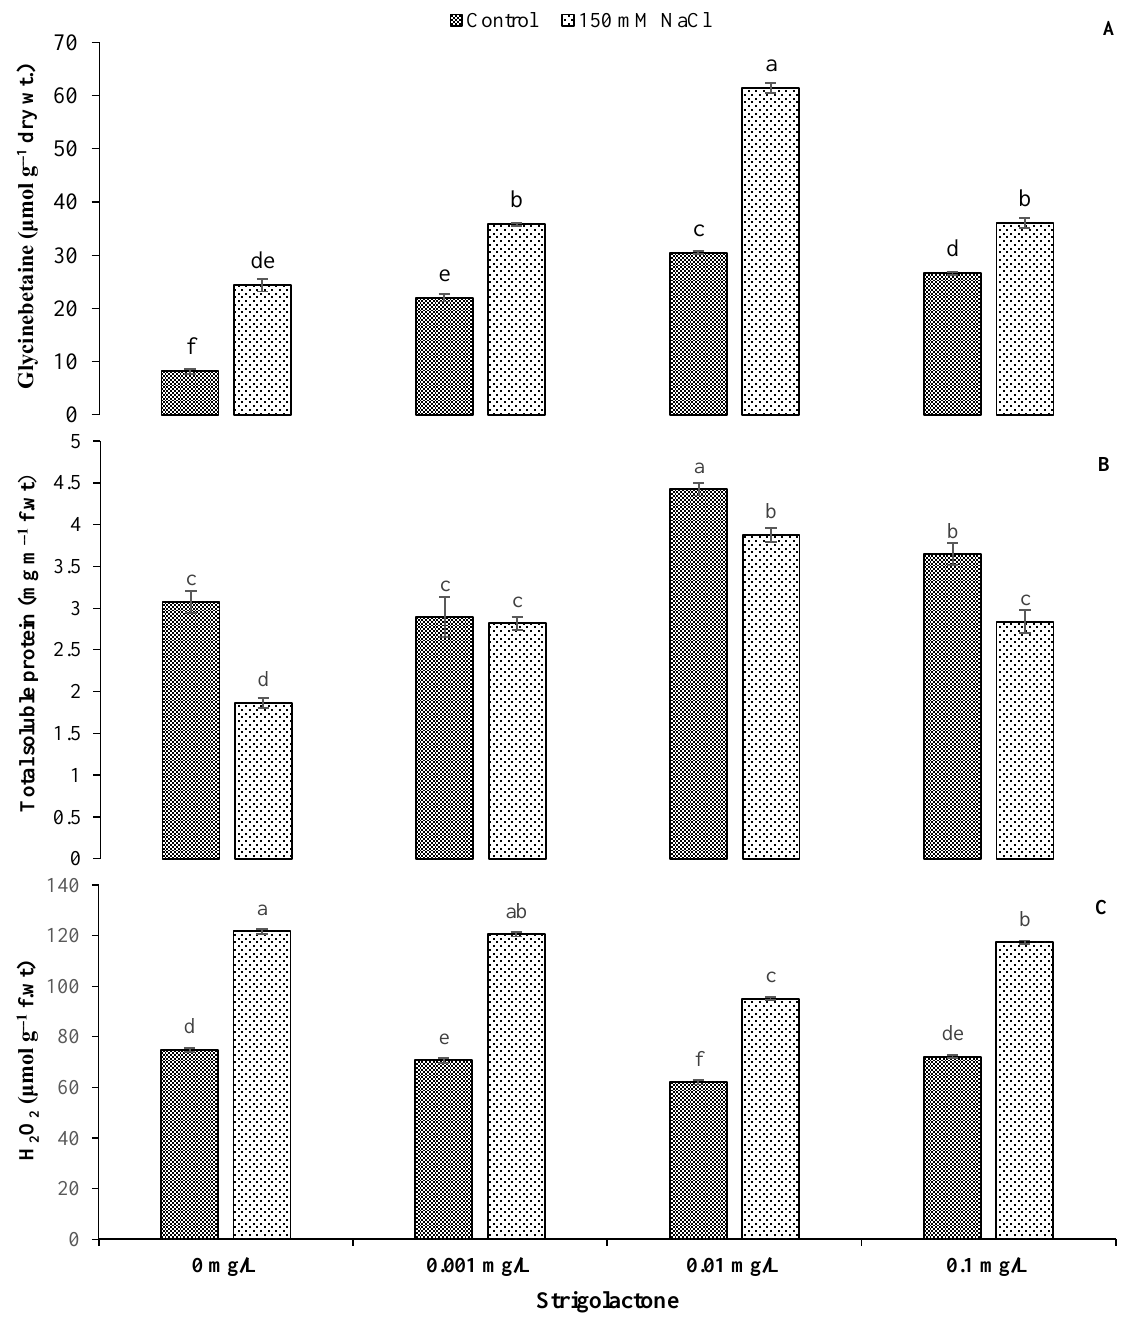
Figure 4. Impact of GR24 on glycinebetaine ( A ), total soluble protein ( B ) and hydrogen peroxide ( C ) of ornamental sunflower under control and salt stress conditions. Each vertical bar shows the mean of three replicates. Different letters indicate significant differences among treatments at p ≤ 0.01 according to least significant difference test.